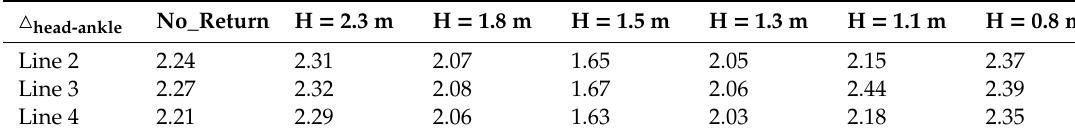
Table 3. Head-ankle temperature difference (°C) for different settings.